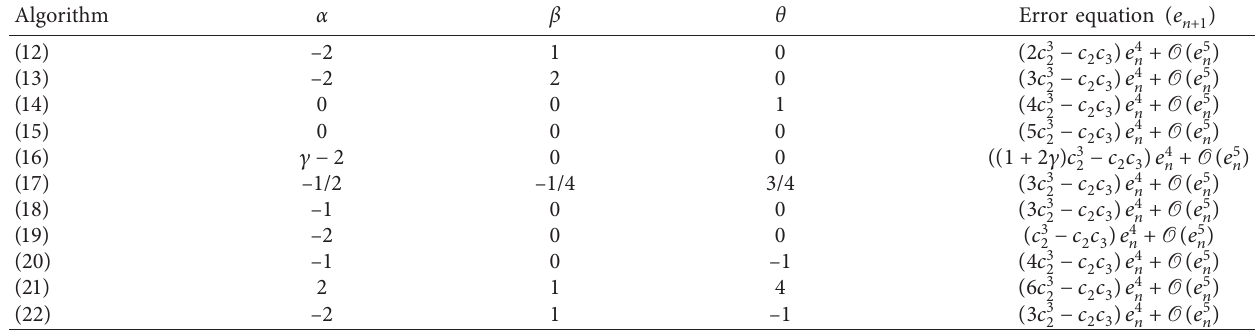
Table 1: The comparison of different iterative schemes on the error